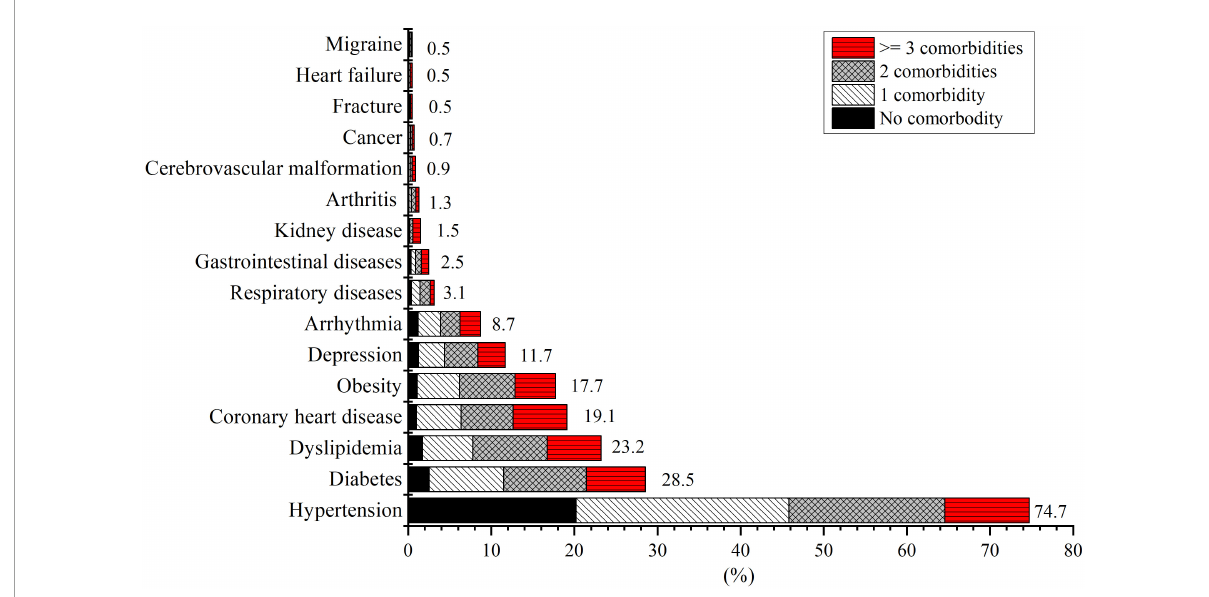
FIGURE1 Prevalence (per 100 patient population) and co-occurrence of chronic diseases among patients with first-ever acute ischemic stroke ( n = 2,151). Comorbidity refers to chronic diseases other than the specific condition and